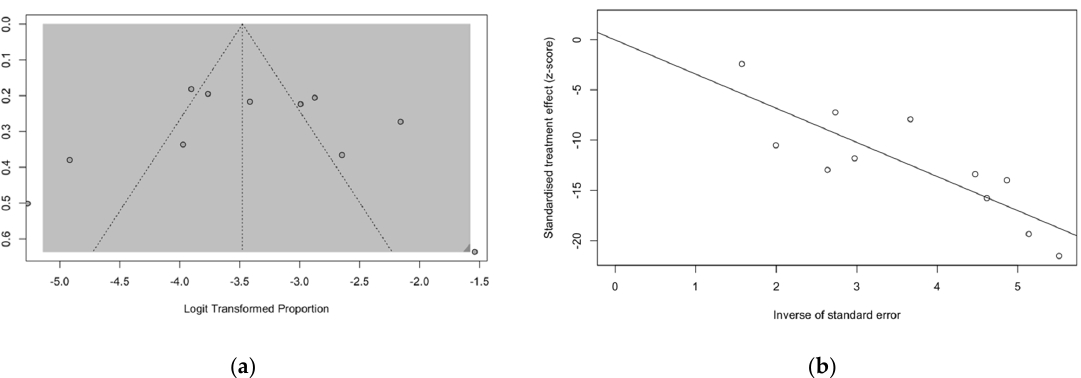
Figure 4. Funnel plots for studies included in the meta-analysis ( a ). Visual inspection suggested that publication could be ruled out, as otherwise confirmed by the results of Egger test (t = − 0.01, df = 9, p -value = 0.990). ( b ) Similarly, in radial plots ( b ), the estimates for included studies were substan- tially scattered across the regression line, suggesting the ruling out of a potential small study